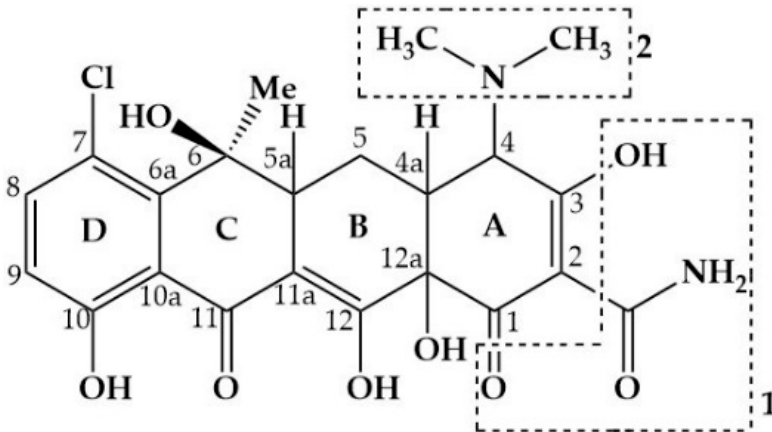
Figure 1. Chemical structure of CTC.